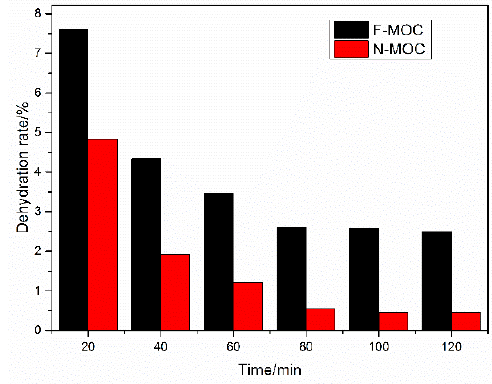
Figure 14. The dehydration rate of F-MOC and MOC (F-MOC and N-MOC bulk density are both around 600 Kg·m −3 , blistering time is 120 Min, the temperature is 30 °C).